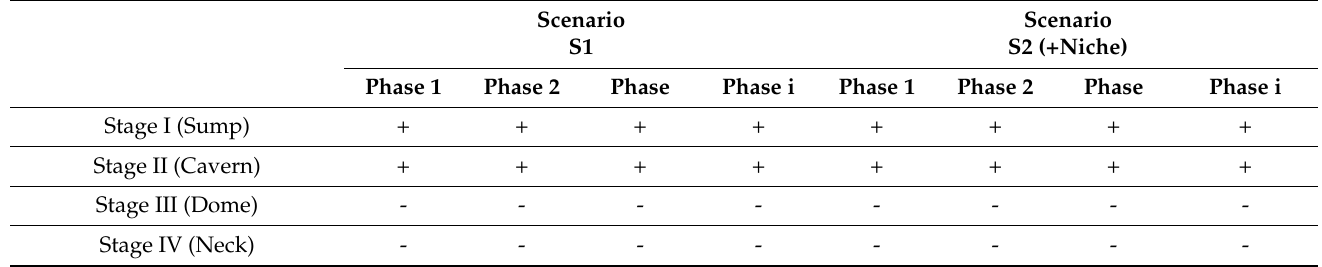
Table 1. Stages and phases of the analysis.